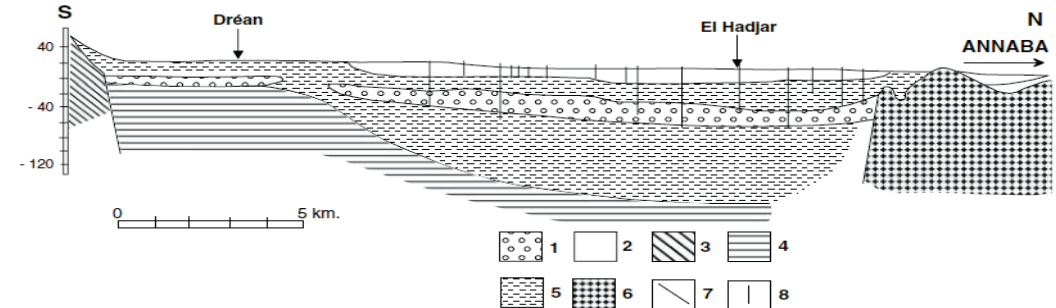
Fig. 2 Geologic cross-section of the studied area. Legend: 1, Clay loam with sand past (groundwater); 2, Plio-Quaternary detrital clay; 3, Metamorphic Socle (micashiste, gneisses, marbles); 4, Numidian sandstone; 5, Pebble and gravel (deep aquifer); 6, Numidian or Paleocene clay; 7, Faults; 8, Drilling.